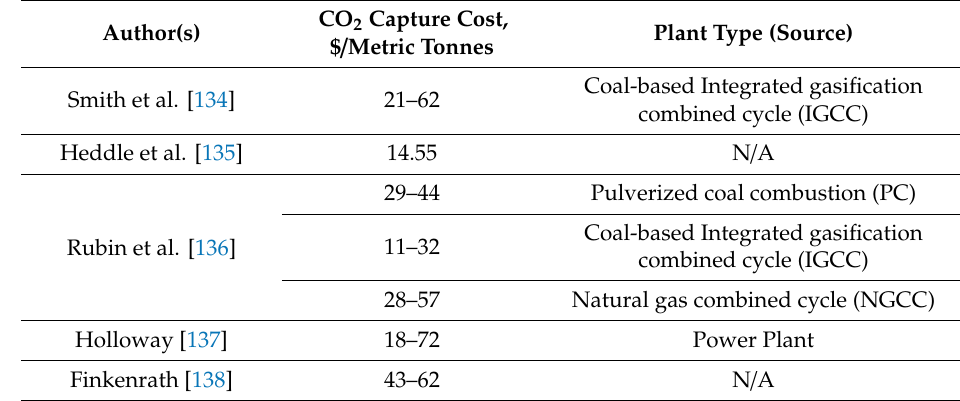
Table 5. Early studies on estimated CO 2 capture cost from di ff erent plants [129].